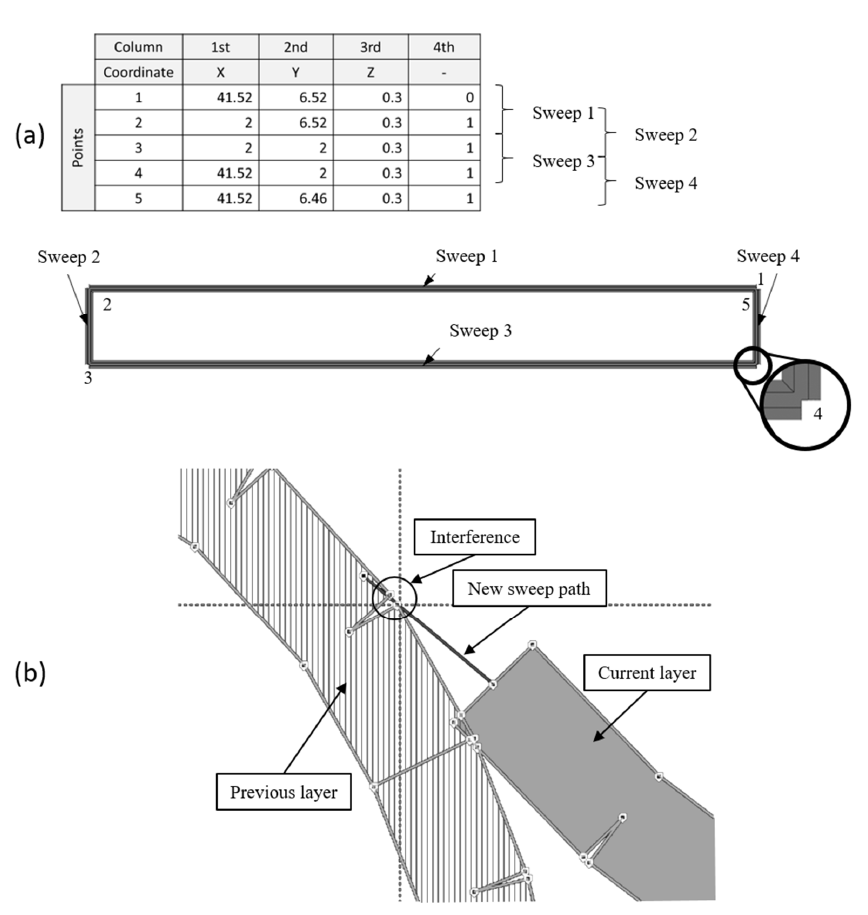
Figure 4. Line-by-line modelling ( a ) and its error ( b ).